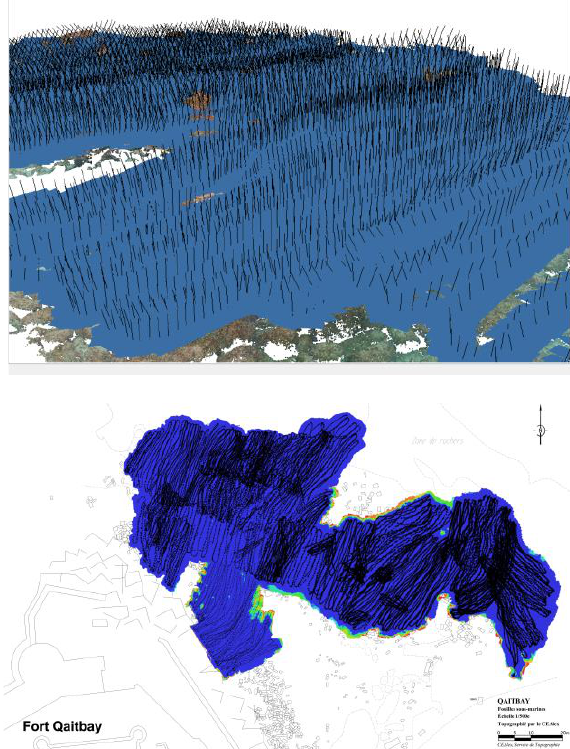
Figure 19. Above, from left to right an orthophoto (season 2014 and 2016) showing the different level of sand; below, Inspection Overlapping Area